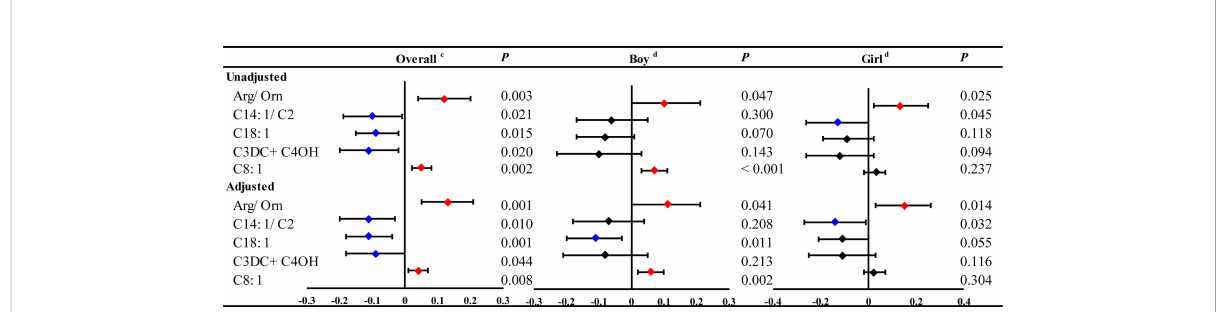
FIGURE 5 The signi fi cant linear associations of maternal and neonatal TSH with neonatal metabolites and strati fi ed by genders in boys or girls. GLM Model c adjusted by the age pregnant women, newborn birth weight, gestational age at delivery and gender of newborns. GLM Model d adjusted by the age of pregnant women, newborn birth weight and gestational age at